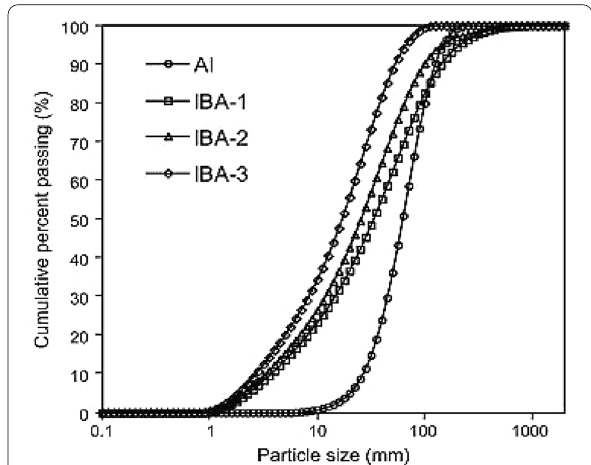
Fig. 3 Particle size distribution curves of three incineration bottom ash and aluminum powder (Song et al.,